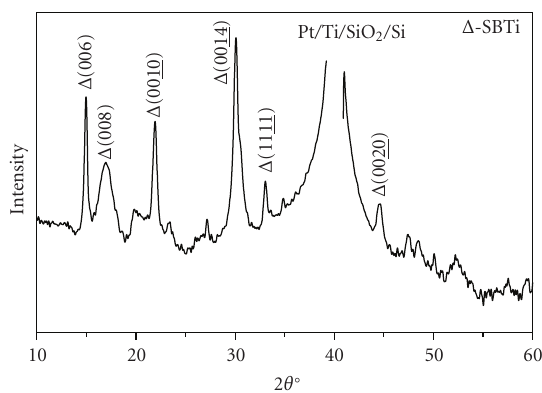
Figure 1: X-ray di ff raction of SBTi film annealed deposited by the soft chemical method at 700 ◦ C for 2